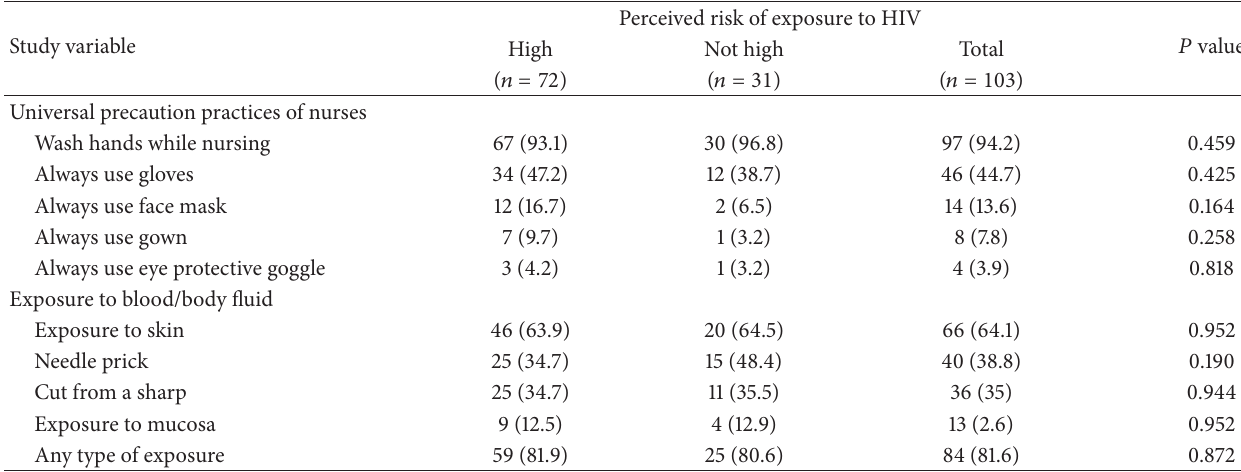
Table 2: Exposure to blood/body fluid and Universal Precaution practices among nursing students according to their perceived risk of exposure to HIV in nursing profession.